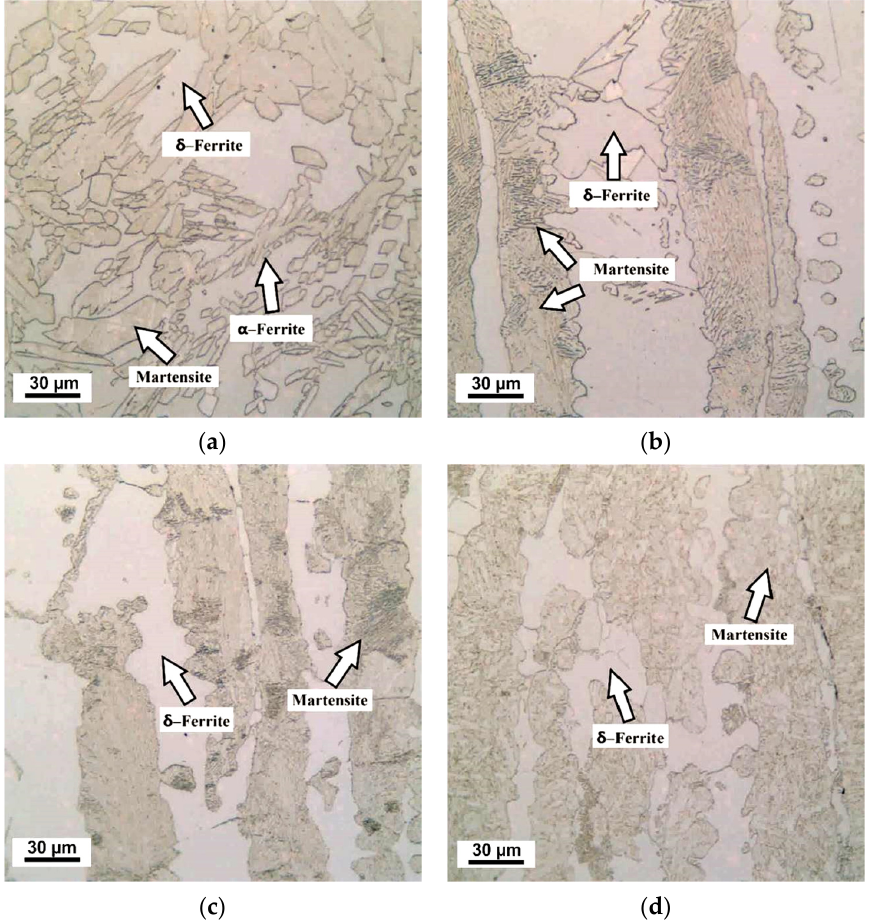
Figure 6. Microstructure in different areas: ( a ) molten zone; ( b ) hardened layer; ( c ) HAZ; ( d ) base metal.